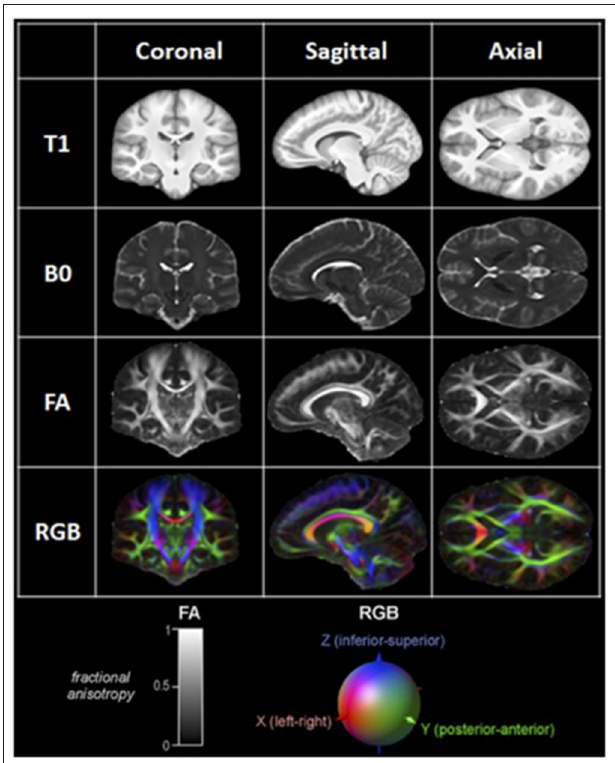
FIGURE 1 | Examples of coronal, sagittal, and axial MRI and DTI images. T1: T1-weighted image. B0: B0 image. FA: Fractionnal anisotropy image; Representation of the level of anisotropy in each voxel on a scale of 0 to 1, as shown in the lower left corner. RGB: Red-Green-Blue Color-coded FA image; Color-coded representation of the main direction of diffusion in each voxel, as shown in the lower right